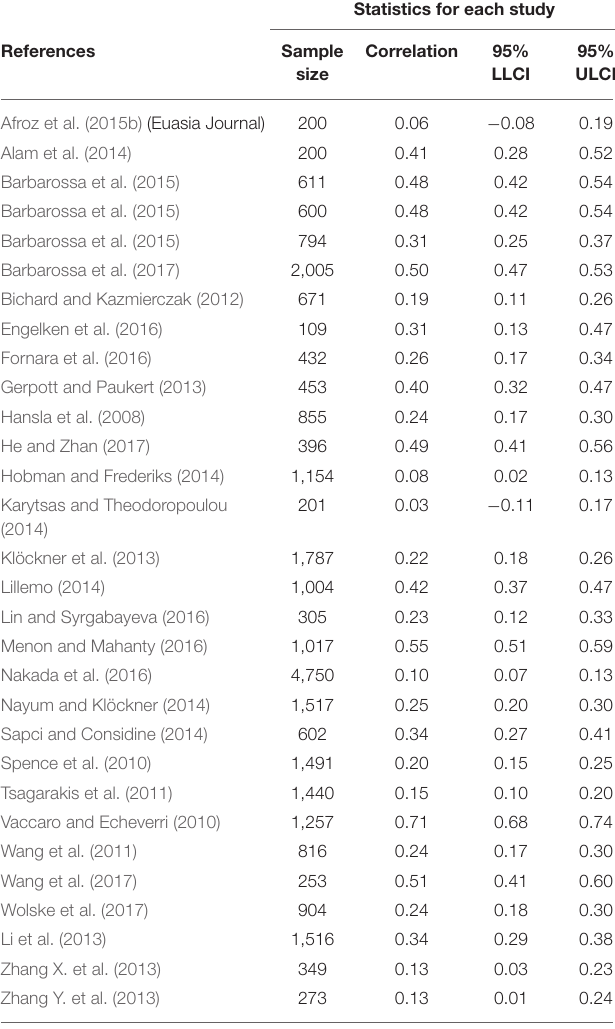
TABLE 4 | Summary of ES of the association between awareness of consequences/beliefs in climate change and energy saving behaviors (or